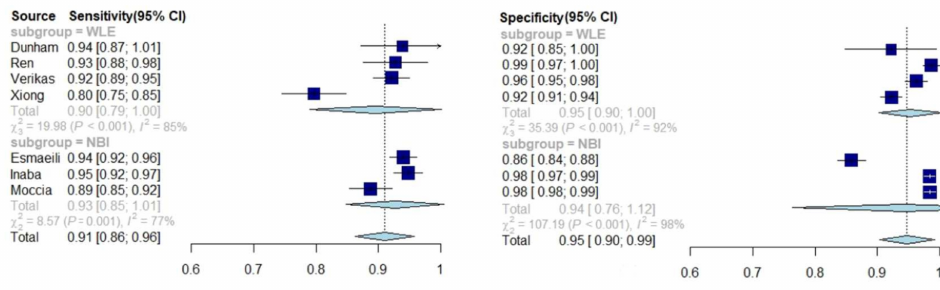
Figure 6. Forest plot illustrating the differences in diagnostic performance of AI using WLE and